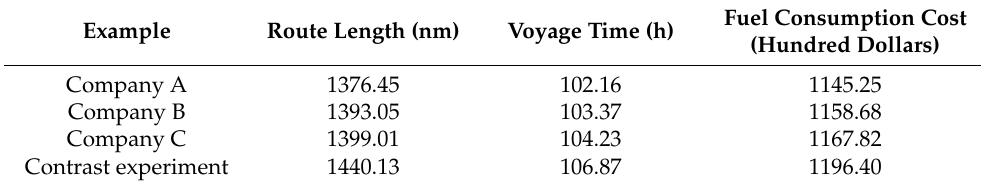
Table 3. Comparison of the IMACO algorithm with the SACO algorithm for 4